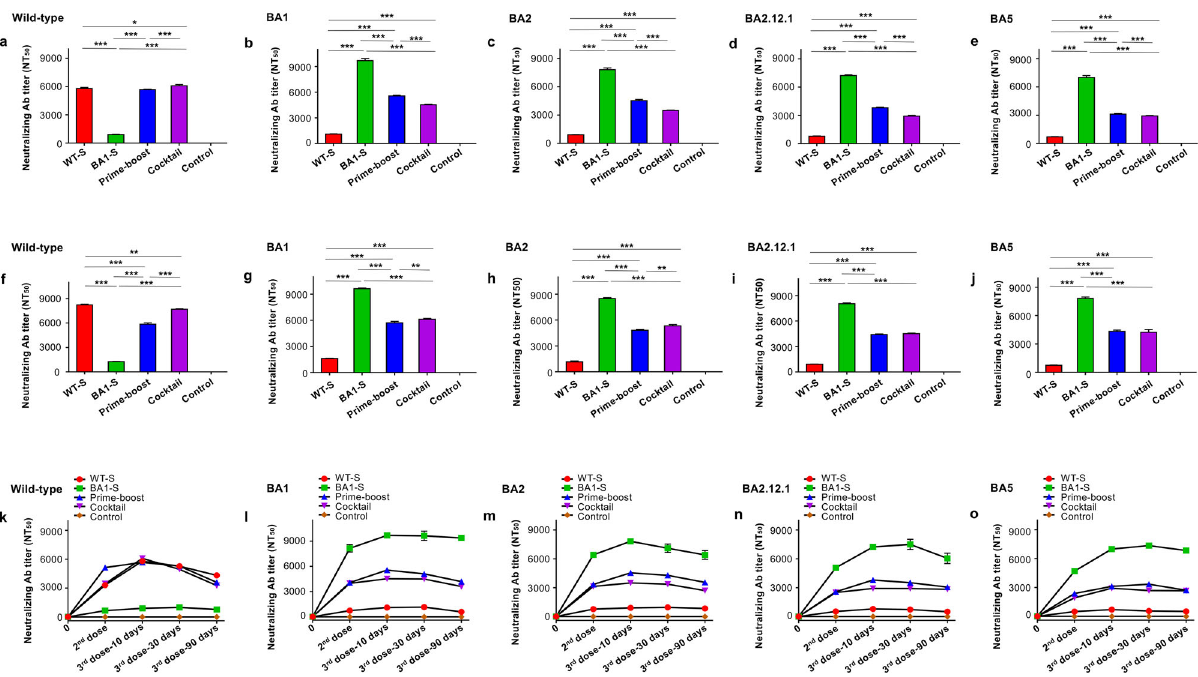
Fig. 2 Cocktail or prime-boost of SARS-CoV-2 WT-S and BA1-S proteins induced potent and durable neutralizing antibodies against four Omicron subvariants and original SARS-CoV-2. BALB/c and K18-hACE2-Tg mice were immunized with WT-S, BA1-S, WT-S prime and BA1-S boost, WT-S and BA1-S cocktail, or PBS control in the presence of adjuvants 3 times at a 3-week interval. Sera were collected 10 days after the second immunization and 10, 30, and 90 days, respectively, after the third immunization for the detection of neutralizing antibodies against pseudotyped viruses encoding the S protein of the original SARS-CoV-2 strain and Omicron subvariants. NT 50 was expressed as 50% neutralizing antibody titers against pseudovirus infection in 293T cells expressing the hACE2 receptor (hACE2/293T). NT 50 against pseudotyped SARS-CoV-2 original wild-type strain ( a , f ), BA1 ( b , g ), BA2 ( c , h ), BA2.12.1 ( d , i ), and BA5 ( e , j ) 10 days after the third immunization in BALB/c ( a – e ) and K18-hACE2-Tg ( f – j ) mice, respectively. NT 50 against the afore-mentioned pseudotyped SARS-CoV-2 original wild-type strain ( k ), BA1 ( l ), BA2 ( m ), BA2.12.1 ( n ), and BA5 ( o ) 10 days after the second immunization, as well as 10, 30, and 90 days, respectively, after the third immunization. The data are expressed as mean ± s.e.m. of quadruple wells from pooled sera of fi ve mice in each